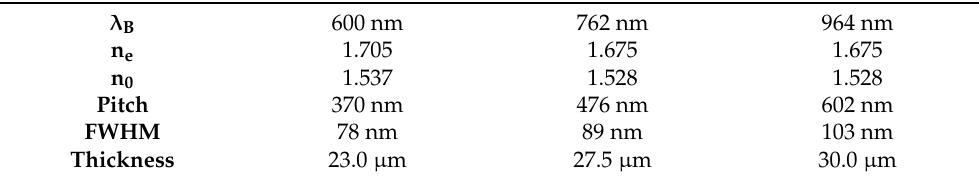
Figure 12. Experimentally measured three PBG data and their theoretical fitting data (solid lines) of the R-PCLC1 cell with three PBG center wavelength positions: 𝜆 (cid:3003) = 600 nm ( o ), 762 nm ( □ ), and 964 nm ( △ ).